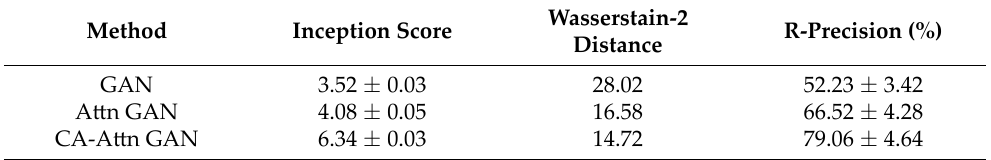
Table 2. Test results on different network models.